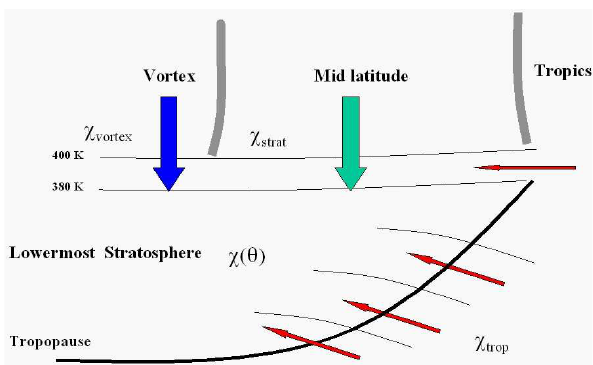
Fig. 1. Transport into the LMS. Air enters the LMS from the mid-latitude stratosphere (green arrow), from the vortex region (blue arrow) and from the troposphere and the lowest part of the tropical stratosphere (red arrows).